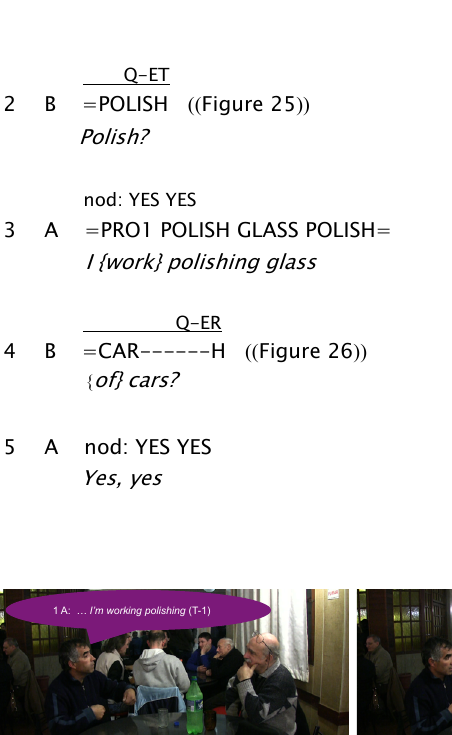
Figure 24. ‘…I’m working polishing’, Person A (left), trouble source of the OIR sequence (line 1).